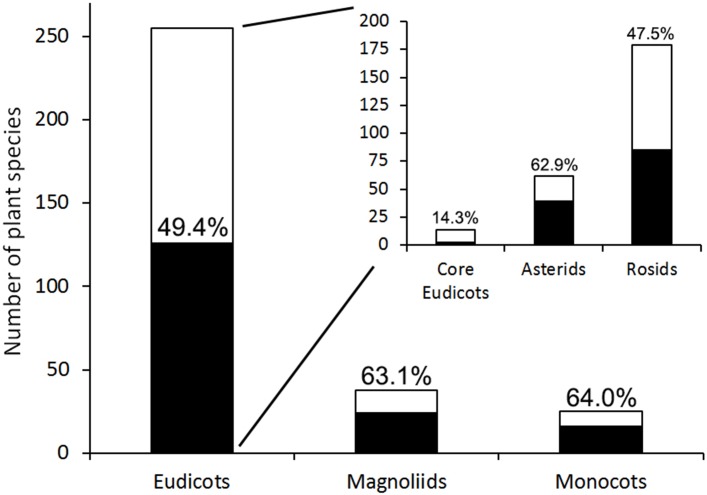
Numbers of Lepidoptera-infested plant species (black bars) relative to the total number of plant species sampled (white bars) for major flowering plant clades.The percentage of infested plant species is shown above the bars. The differences in attack rate between Magnoliids, eudicots and monocots were not significant. Within eudicots, Lepidoptera attacked more frequently asterids (63% of 62 species) than rosids (47% of 179 species, χ21 = 3.8, P = 0.05), and core eudicots (14% of 14 species, χ21 = 9, P = 0.002). Classification according to the Angiosperm Phylogeny Group (APG III 2009).